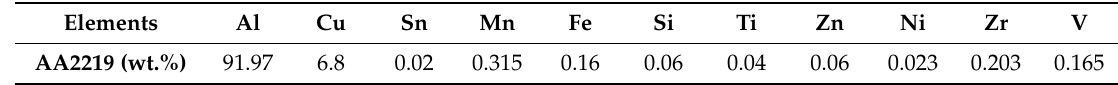
Table 1. Chemical composition of AA2219-O.